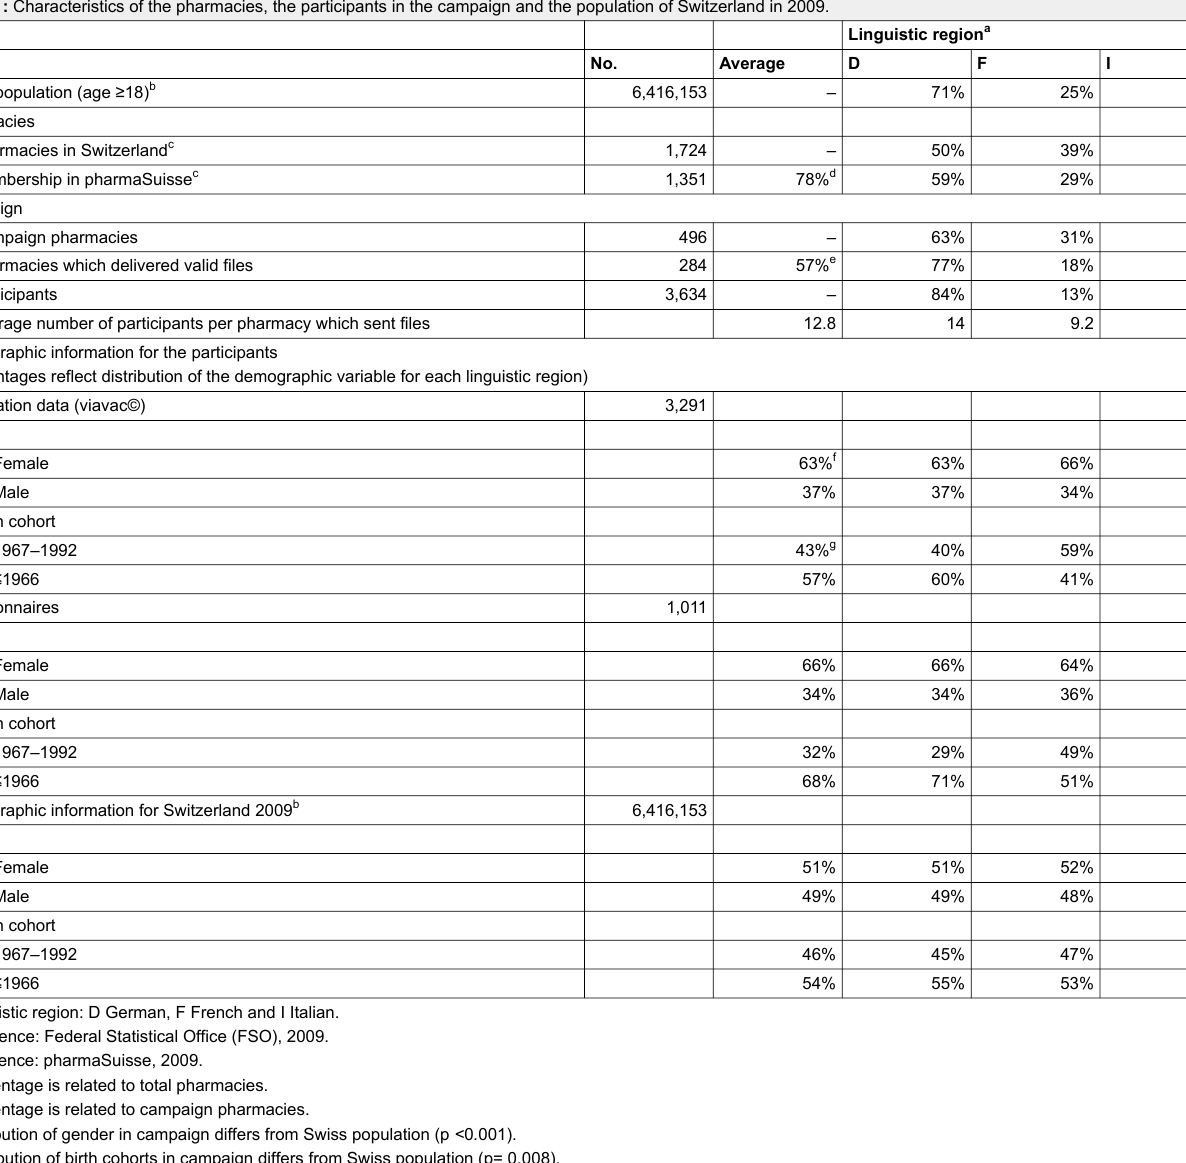
Linguistic region